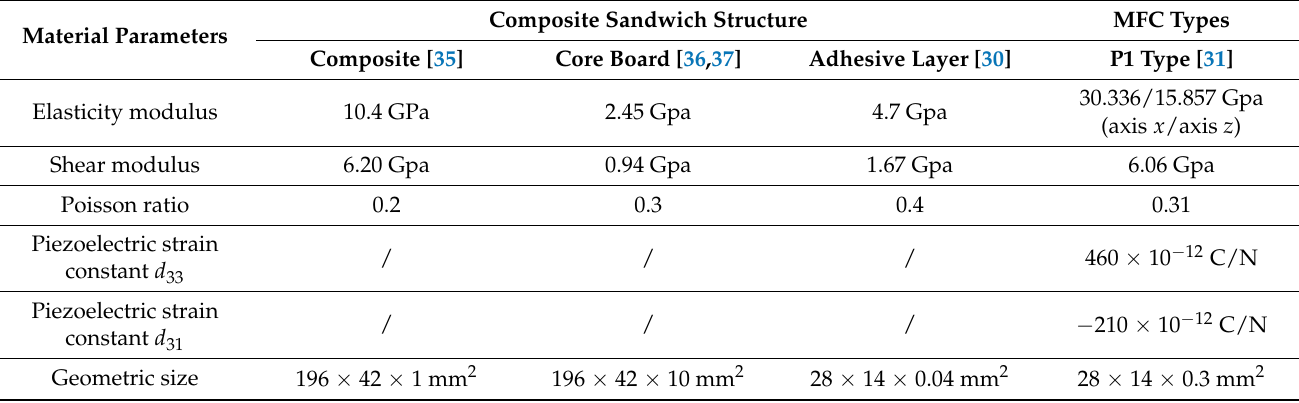
Table 1. Material parameters of the MFC and sandwich plate structure.